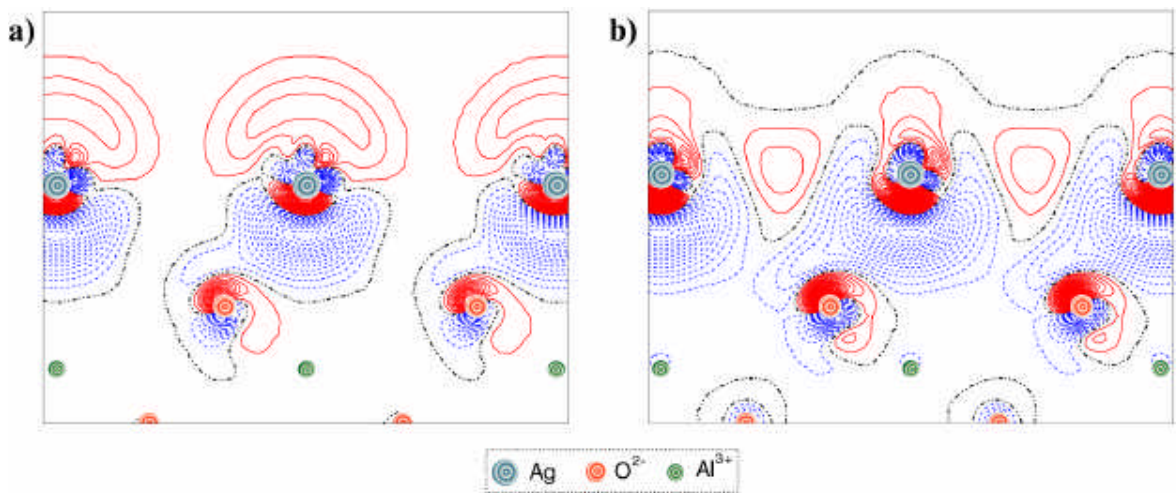
Figure 4 . Cross-sections of difference electron density distributions Dr ( r ) defined by Eq. (2) for two different coverages in the case of E configurations of silver atoms adsorbed on the Al-terminated sub- strate: (a) 1/3 Ag ML (Fig. 2b) and (b) 1 Ag ML. In order to mark in the centers of atoms and ions ly- ing in the cross-sections shown in Fig. 3, colored circles with the three different patterns are used. Bot- tom borderlines of plots correspond to a central oxygen plane shown in Fig. 2b. Isodensity contours are drawn from –0.3 e au –3 to +0.3 e au –3 with an increment of 0.0004 e au –3 . The full (red), dashed (blue) and chained (black) curves show positive, negative and zero difference densities, respectively. Table 1 . Optimized parameters for different slab models of the Ag/ a -Al atom positions over both equilateral and versatile oxygen triangles for different substrate terminations and coverages are shown in Fig.